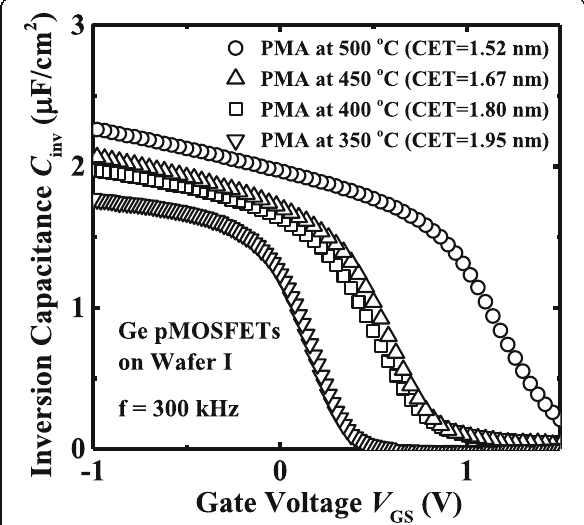
Fig. 2 Inversion C inv - V GS curves for the Ge pMOSFETs on wafer I with a PMA at 350 °C, 400 °C, 450 °C, and 500